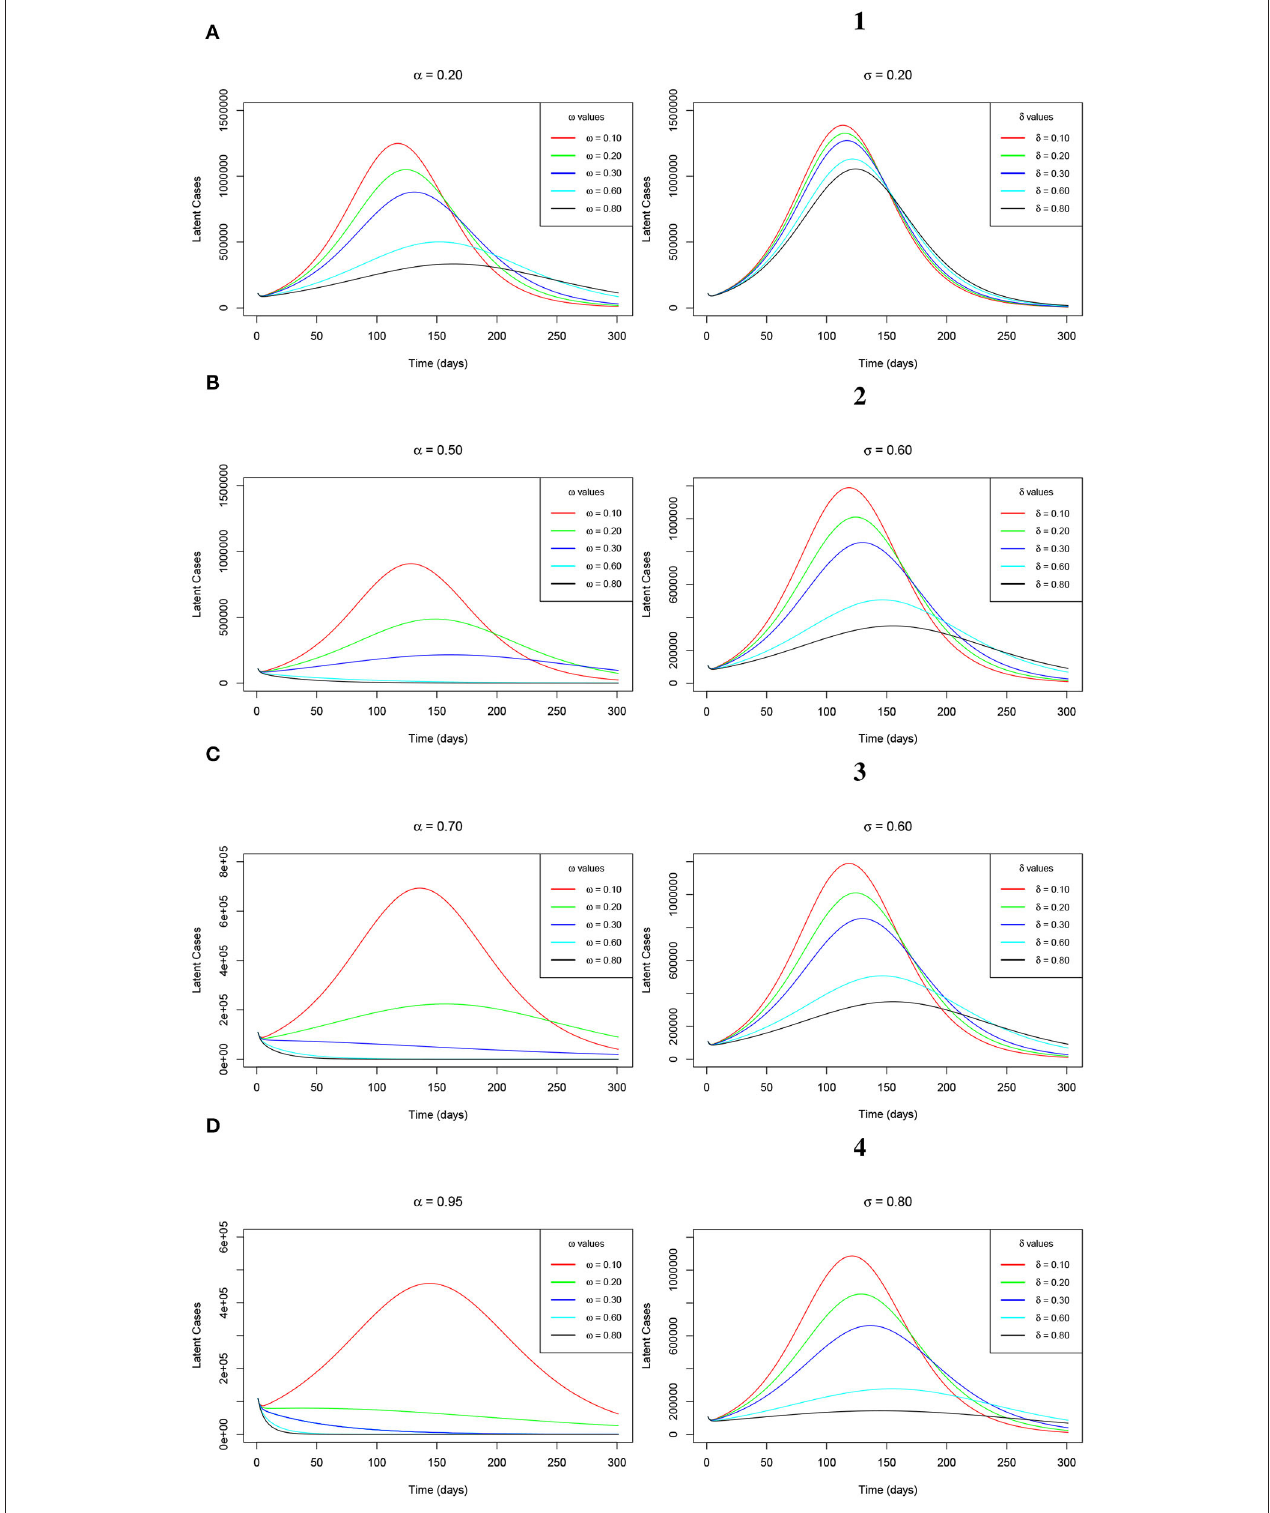
FIGURE 8 | (A–D) Simulations of the model (Equations 2–8) showing the trajectory of the latent cases as ω varies at changing levels of α (left-hand-side sub-figures) and the latent cases as δ varies at changing levels of σ (right-hand-side sub-figures).